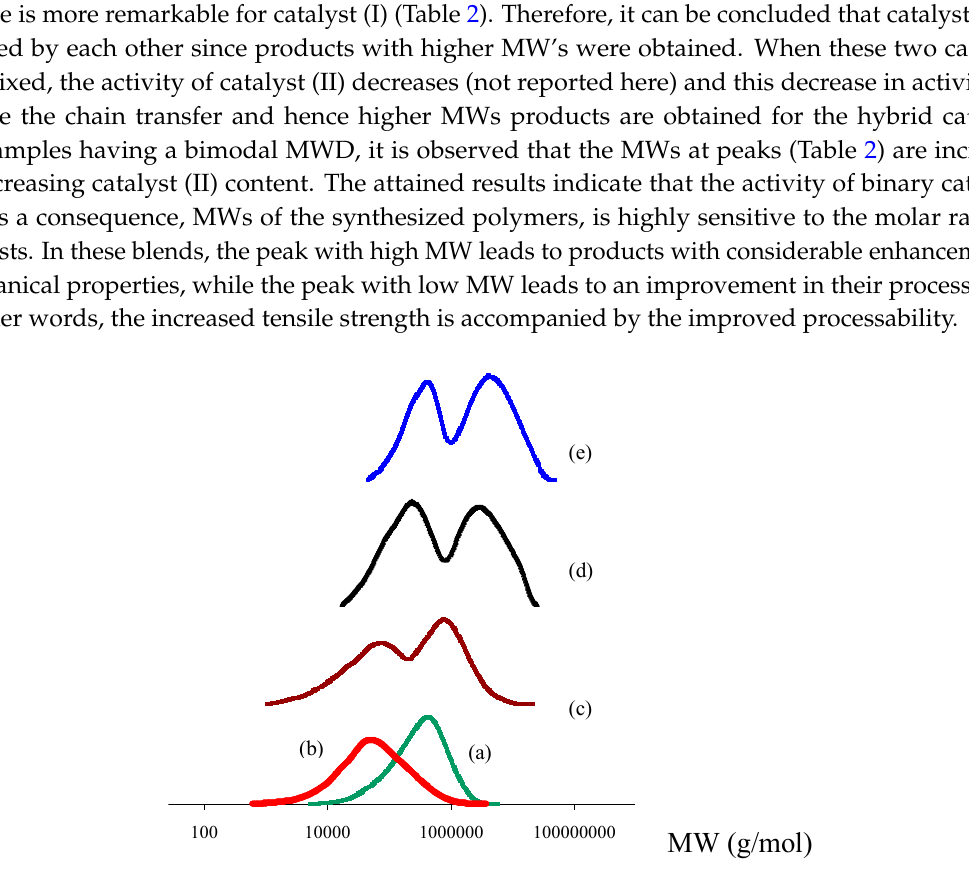
Figure 1. MWD Curves of the synthesized PP reactor blends by use of individual and binary catalysts: ( a ) PP-Cat I; ( b ) PP-Cat II; ( c ) PP-H Cat (25); ( d ) PP-H Cat (32); ( e ) PP-H Cat (40). Table 2. MW and MWD of the synthesized PP reactor blends.